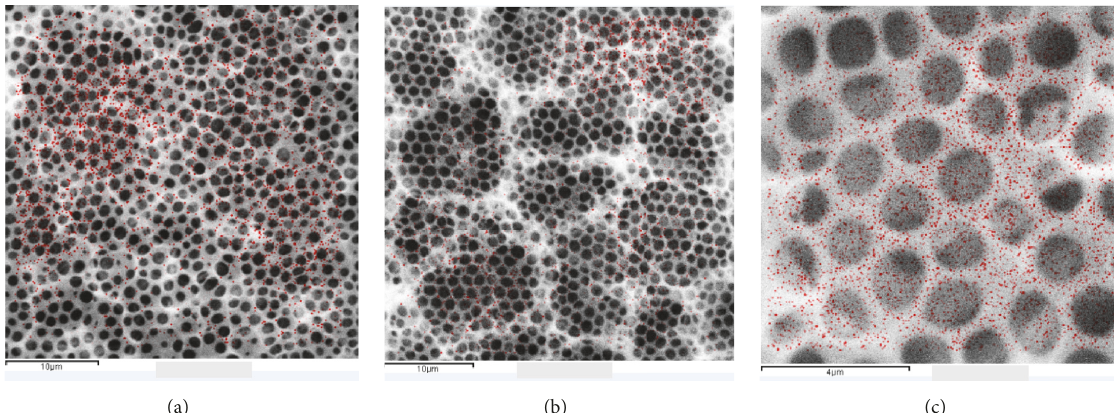
Figure 3: Influence of particle hydrophobicity concentration on the final porous structures. (a) 25% SiOH, (b) 75% SiOH, and (c) 100% SiOH. The red dots are the distribution of Si element.